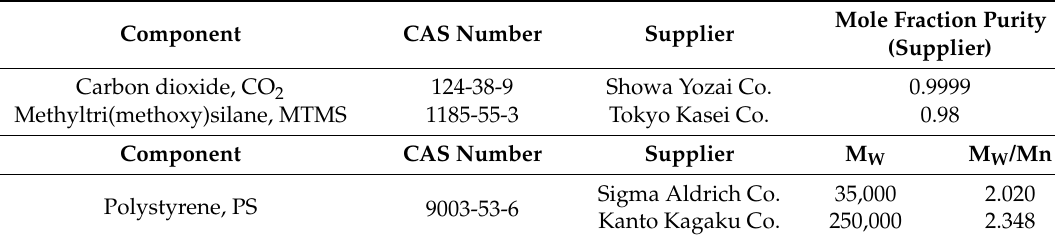
Table 1. Specifications of the pure